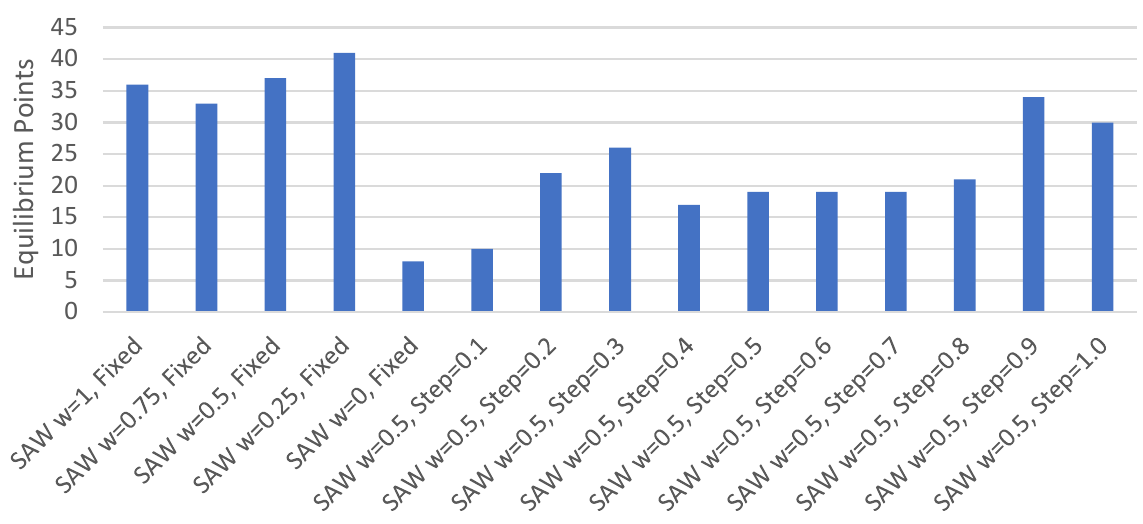
Figure 11. Equilibrium points with TIS and direct